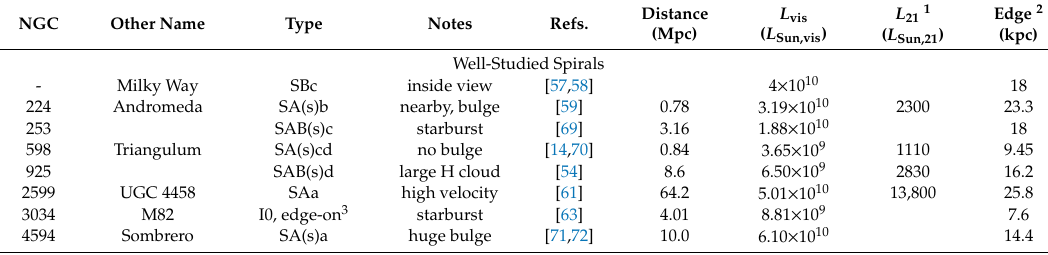
Table 4. List of studied galaxies with characteristics from the NASA / IPAC Extragalactic Database (NED [23]) and references for RC